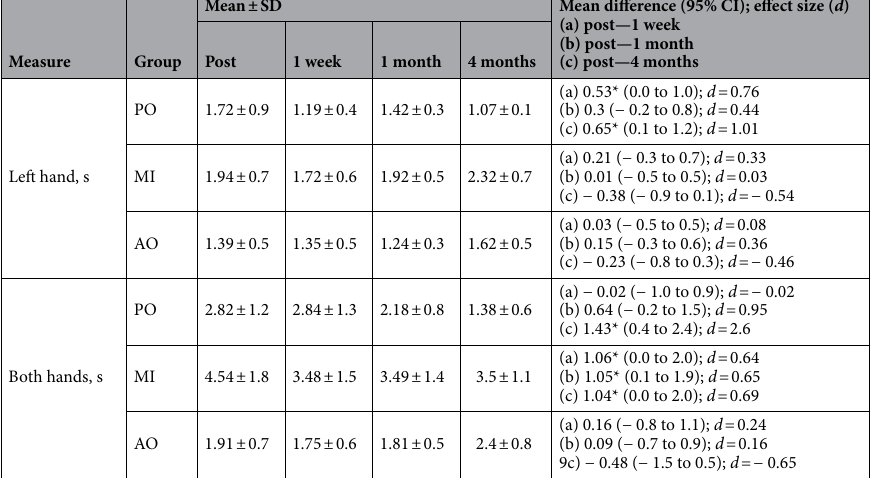
Table 3. Intragroup differences in requested time outcome measurement. *p < 0.05; **p < 0.001. AO action observation group, CI confidence interval, m month, MI motor imagery group, PO placebo observation group, s seconds, SD standard deviation, w